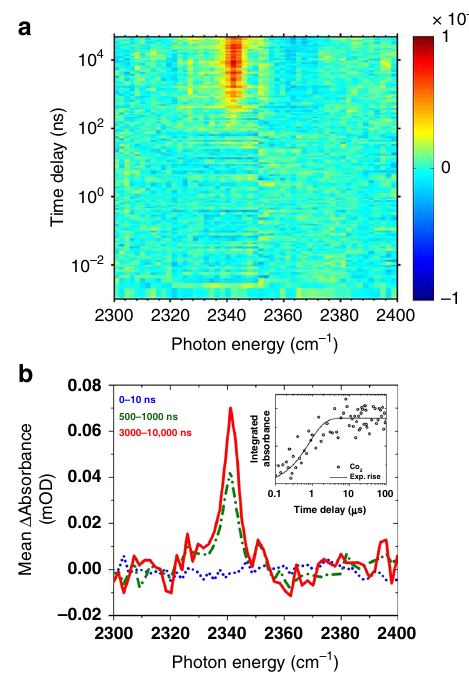
Fig. 3 Time-resolved photocatalytic decarboxylation. a False color map of the TRIR spectrum of the full reaction mixture — PHEN (4 mM): DCB: CHCA: NaOH = 1:4:6:6 — photoexcited at 256 nm and measured in the region of the antisymmetric stretch of the reaction byproduct (CO 2 ). The time axis is plotted on a logarithmic scale for clarity. Amplitude units, highlighted by the color map, are in Δ OD. b Transient absorption spectra averaged over representative time-windows (0 – 10 ns in dotted blue, 500 – 1000 ns in dash-dotted green, 3 – 10 μ s in solid red). The inset shows a kinetic trace of the integrated absorbance of this peak on a logarithmic time-axis, and fi tted to a single-exponential